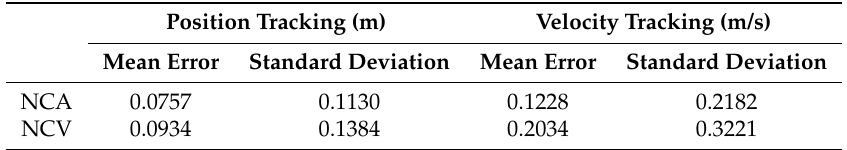
Table 6. The comparison of position and velocity tracking errors by Kalman filter with (NCA) or without (NCV) acceleration